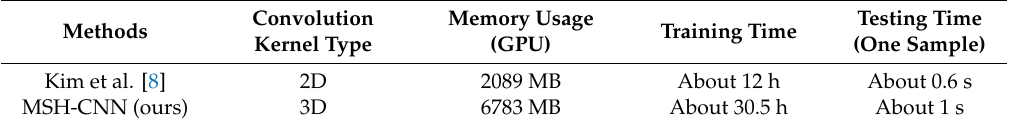
Table 6. The cost of two-dimensional (2D) and 3D networks. GPU—graphics processing unit. Methods